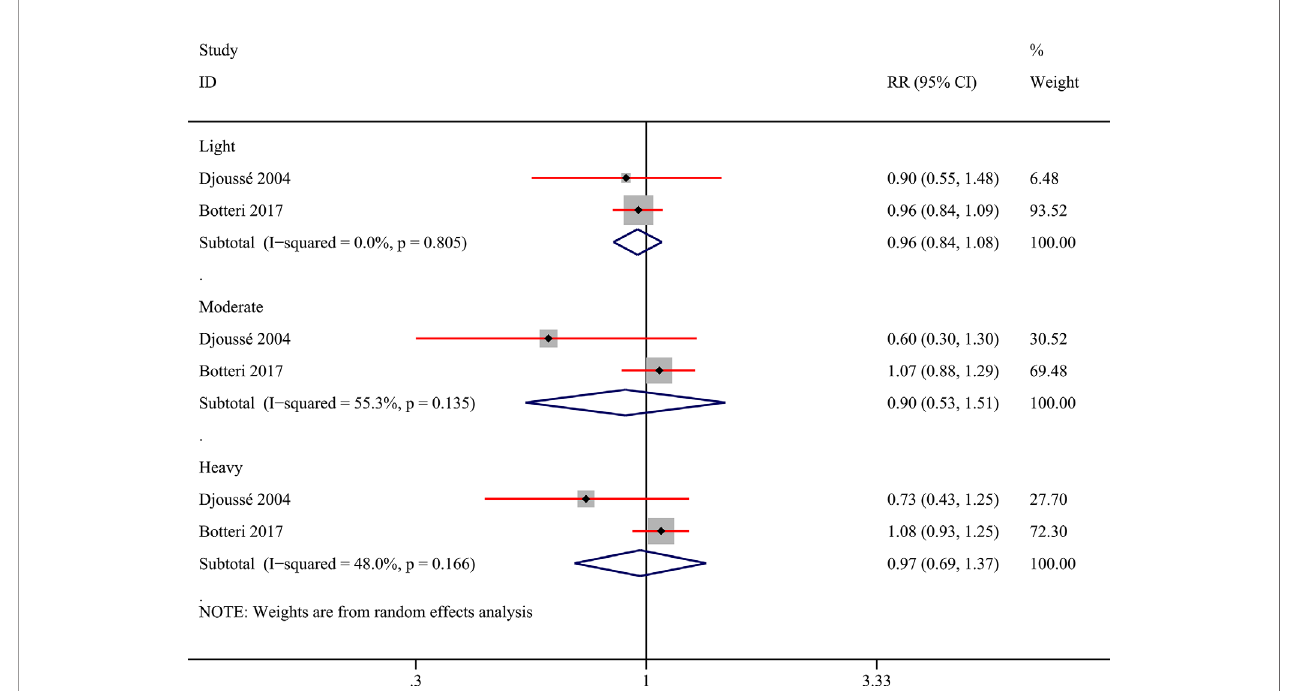
FIGURE 4 | Forest plot of relative risk (RR) of bladder cancer for alcohol consumption (Light, moderate, and heavy versus none) in the entire